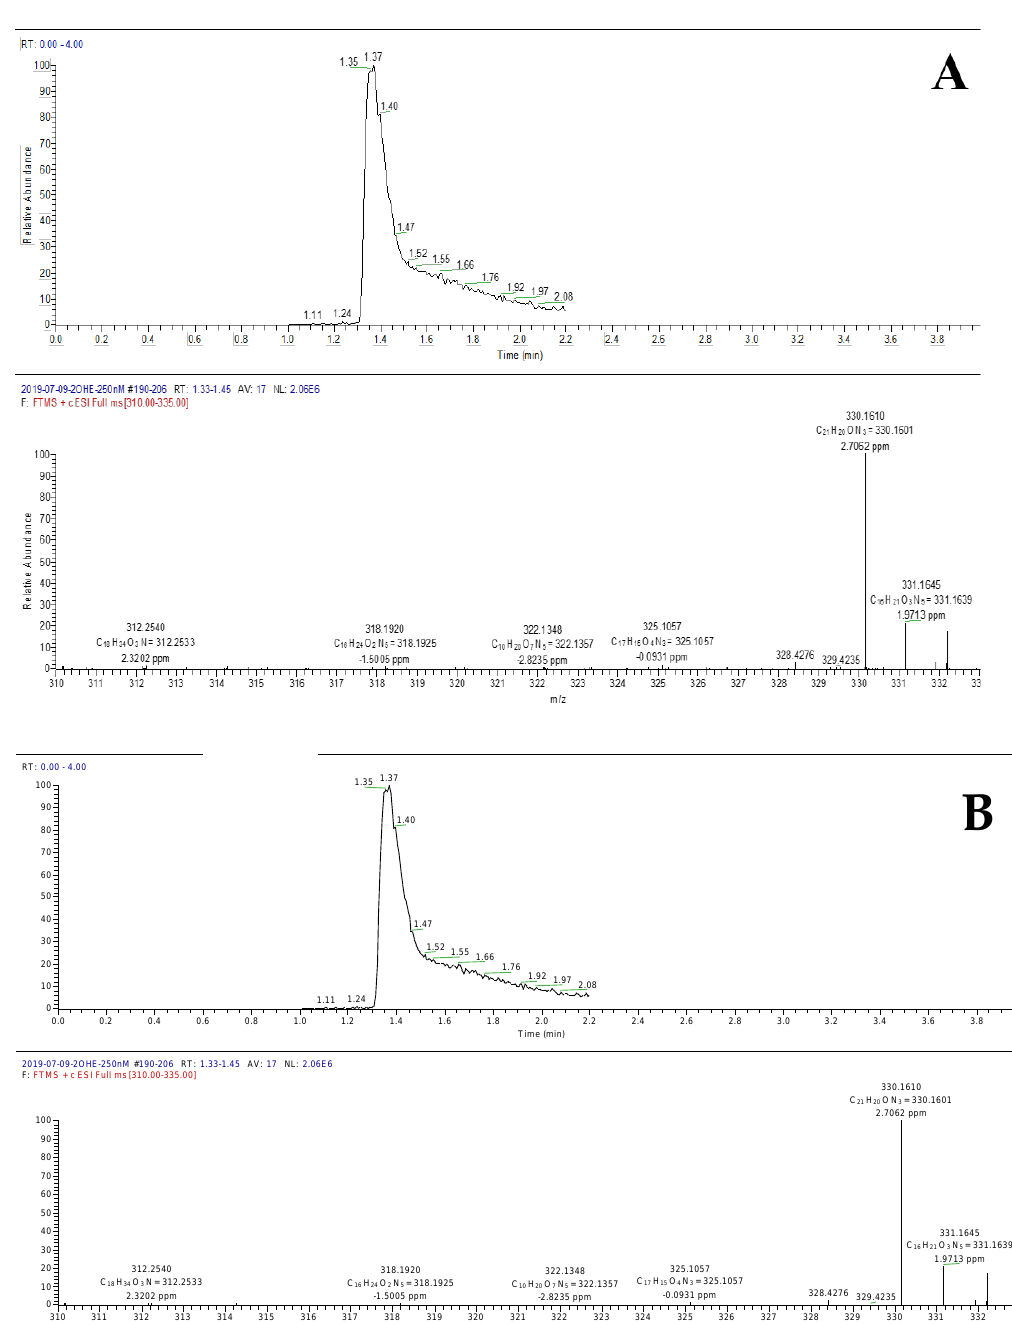
Figure 4A,B. The corresponding concentration of superoxide and hydrogen peroxide deduced from the calibration curves are presented in Figure 5. As demonstrated, a significant increase (approximately 4 folds) of both species was observed for PHZ treated RBC in comparison with untreated ones. The concentration increased from 10 to 50 nM for O 2 • - and from 25 to 100 nM for H 2 O 2 .